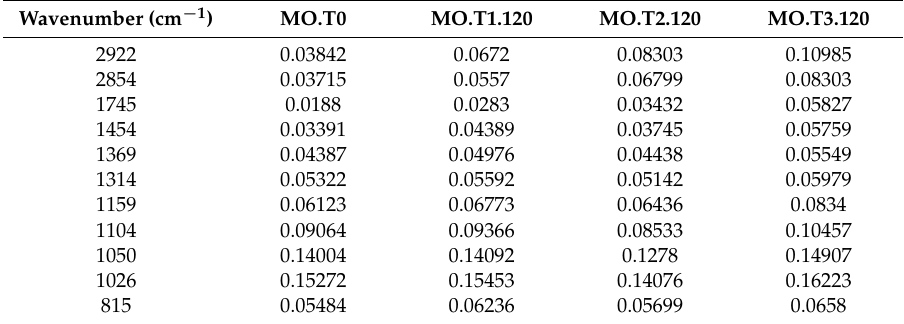
Table 3. Peak absorbance values of IR spectra of paper samples aged in mineral oil at 120 °C.